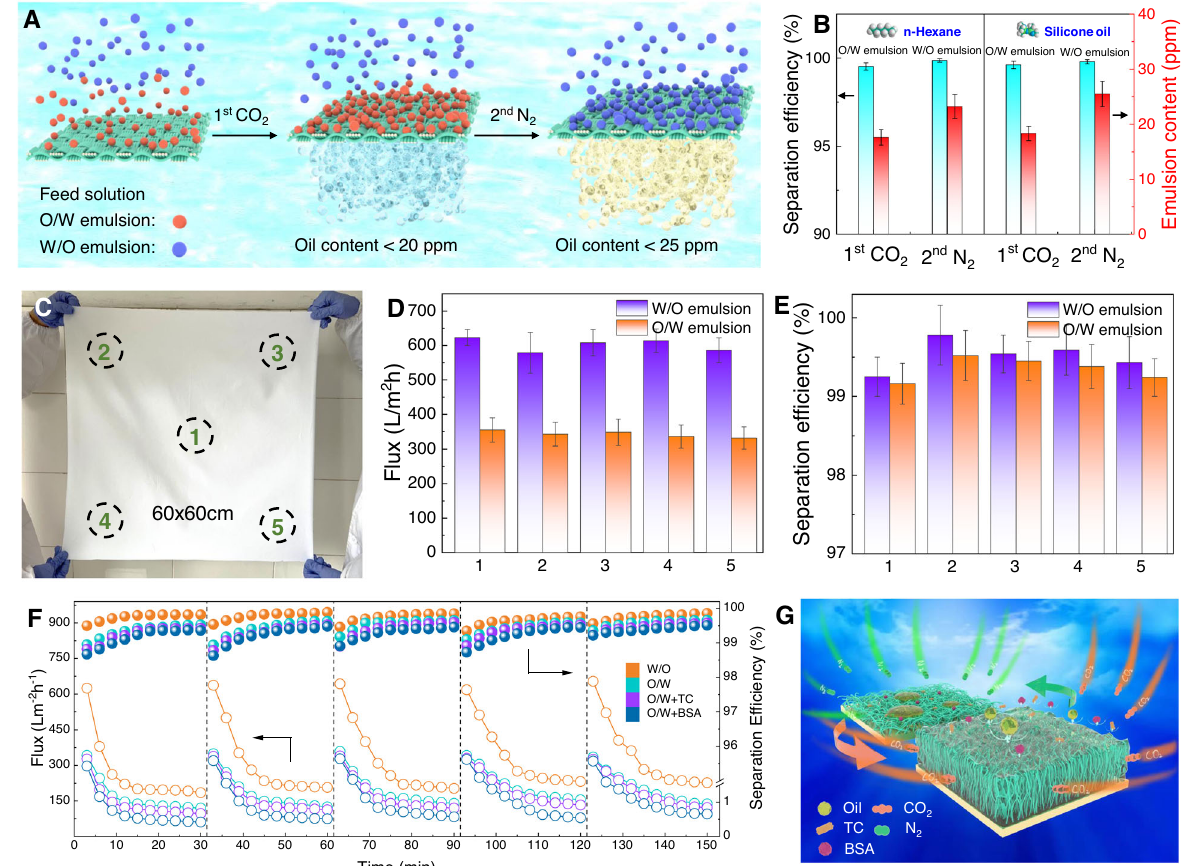
Fig. 5 | Gas switchable multiphase emulsion mixtures separation and self- cleaning performance. A Schematic showing the two-step separation process for themultiphaseemulsionsystemunderCO 2 /N 2 stimulation. B Separationef fi ciency of PPFM-0.5 with gap width of 150 μ m in the 1st and 2nd step operations. The emulsion content is oil content for O/W emulsion and water content for W/O emulsion, respectively. C Photo of the prepared large-size PPFM with 60×60cm. D , E Separation ef fi ciency and fl ux of the selected area in PPFM with gap width of 150 μ m for both W/O and O/W emulsions at 25°C. The W/O and O/W emulsions